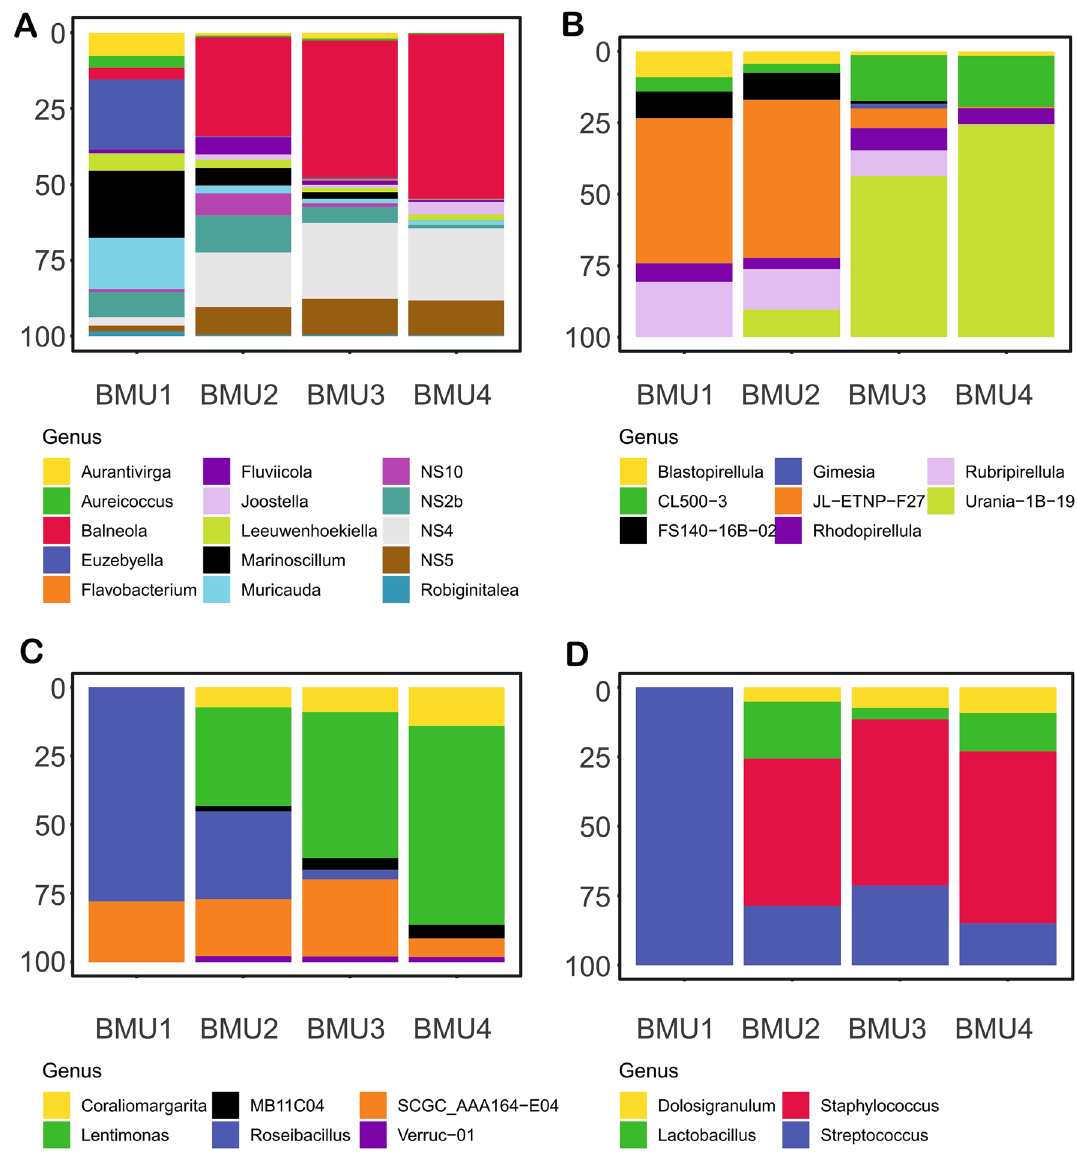
Figure 6. Characteristic genus contribution ( A ) Bacteroidota ( B ) Planctomycetota ( C ) Verrucomicrobia ( D ) Firmicutes. The figure was generated in R statistical software 35 (https:// cran.r- proje ct. org/ , v. 3.6.3), using ggplot2 v. 3.3.3 package 36 , and they were assembled in Inkscape (https:// inksc ape. org/ , v. 0.92).